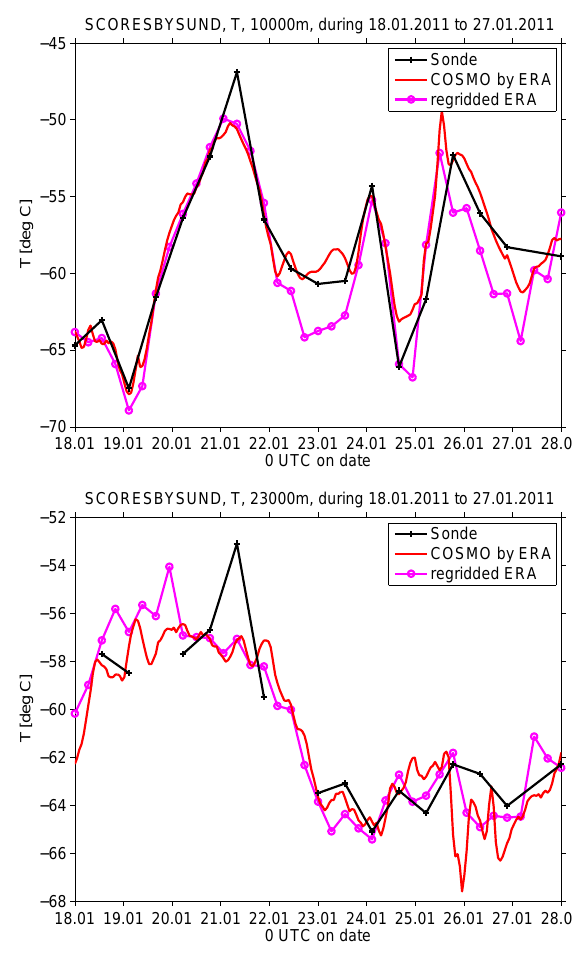
Figure 10. Time series of measured and modeled temperature as well as the regridded boundary data, 10 (top) and 23km (bottom) above Scoresbysund, station no. 19, over 10 days at the end of Jan- uary 2011. All data points available in each data set are